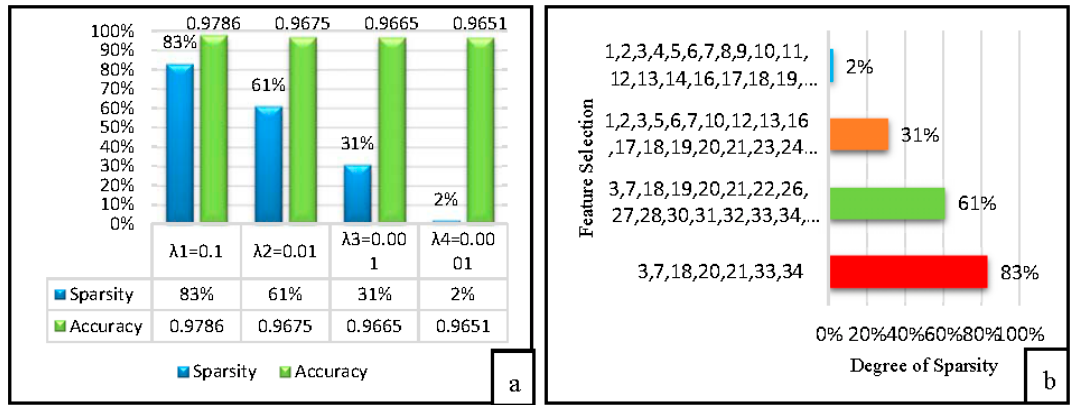
Figure 5. ( a , b ) Overall Classification Accuracy (OCA) and Feature Selection (FS) along with degree of sparsity by SPLR on KDD ’99.